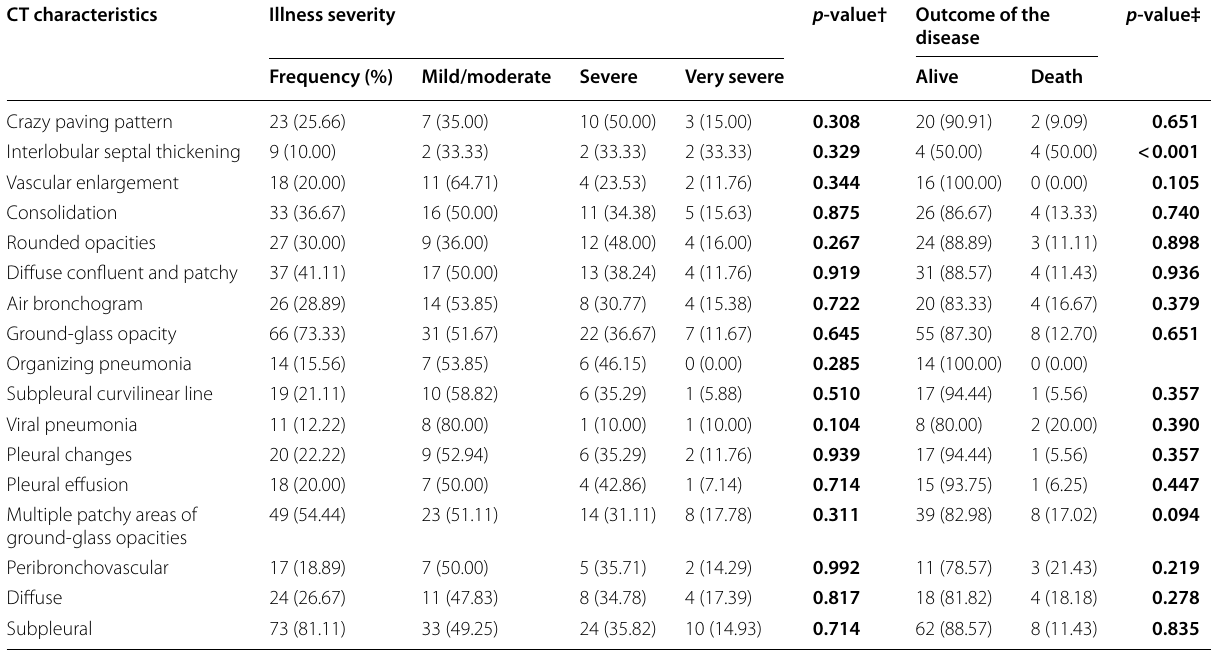
† p ‑value from Pearson’s chi‑squared test statistics and one‑way ANOVA between illness severity and CT characteristics ‡ p ‑value from Pearson’s chi‑squared test statistics between outcome of the disease and CT characteristics